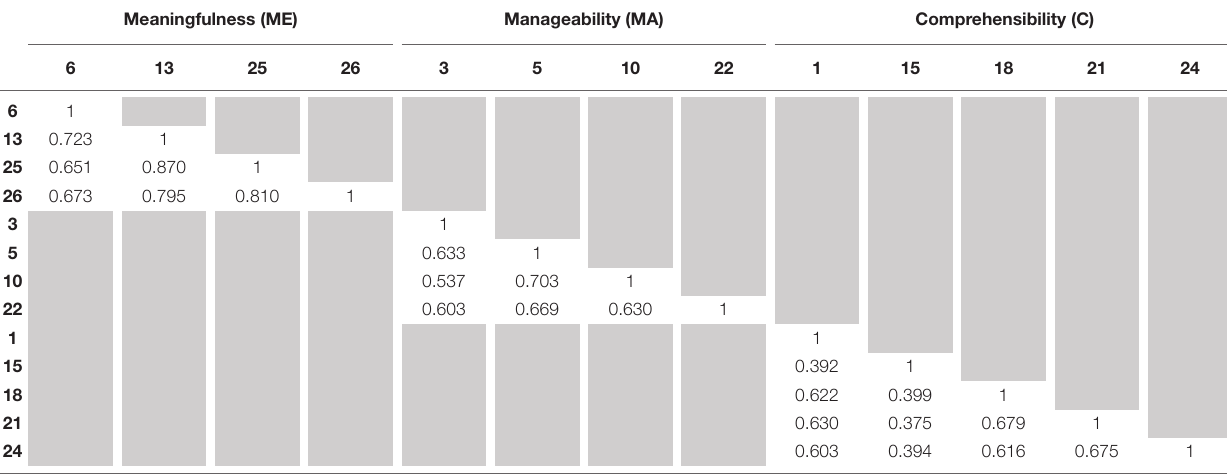
TABLE 3 | Pearson’s R correlation between FSOC Scale items.